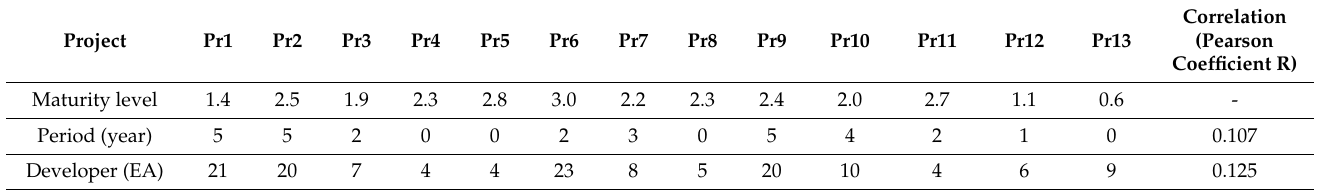
Table 8. Maturity levels, development periods, and number of developers of 13 AI projects.